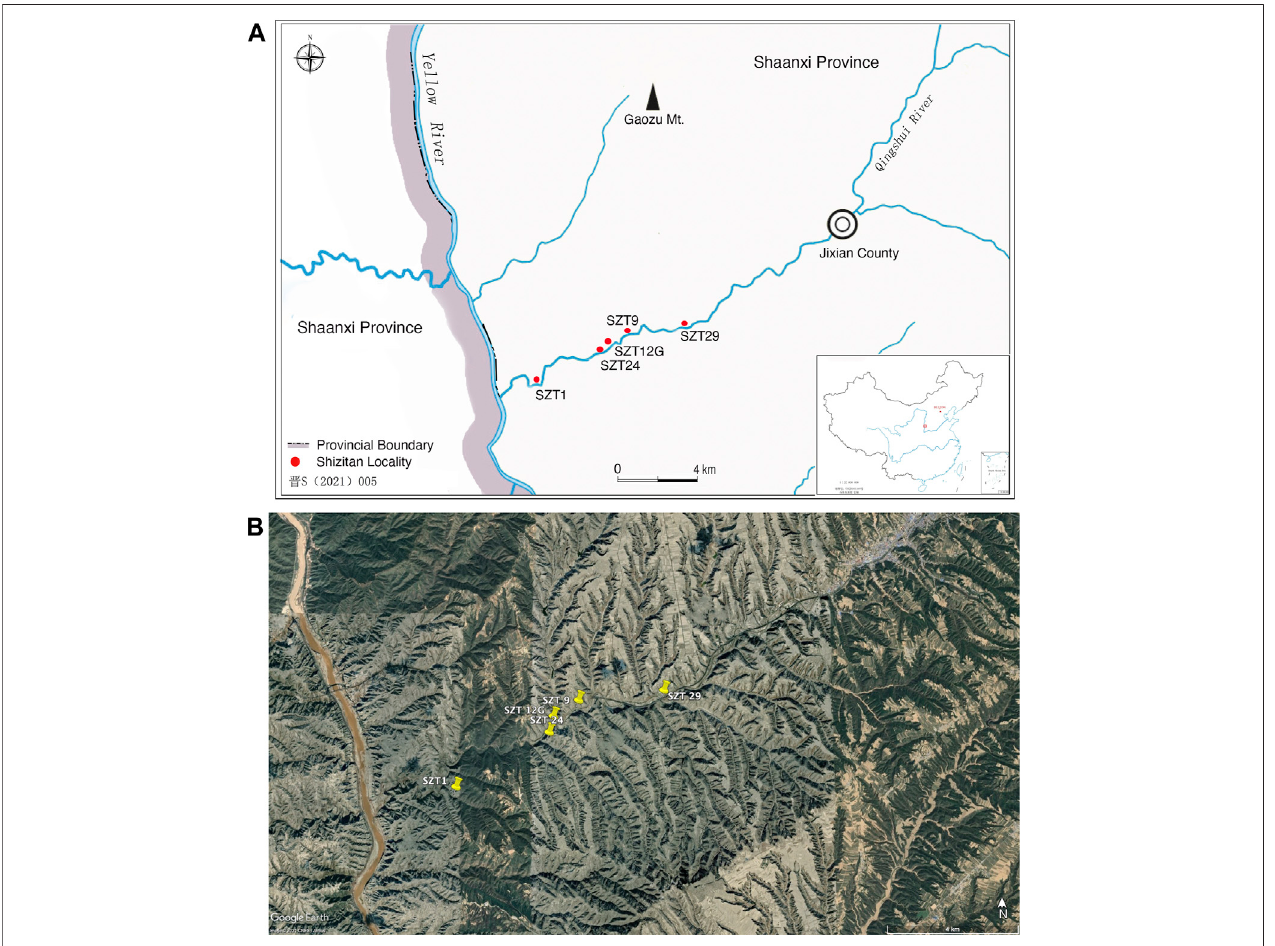
FIGURE 1 | (A) Map showing the locations of the excavated Shizitan localities with OES ornaments, along the Qingshui River, Shanxi Province. (B) Google Earth satellite image showing the positions of the Shizitan localities within the Loess Plateau landscape.